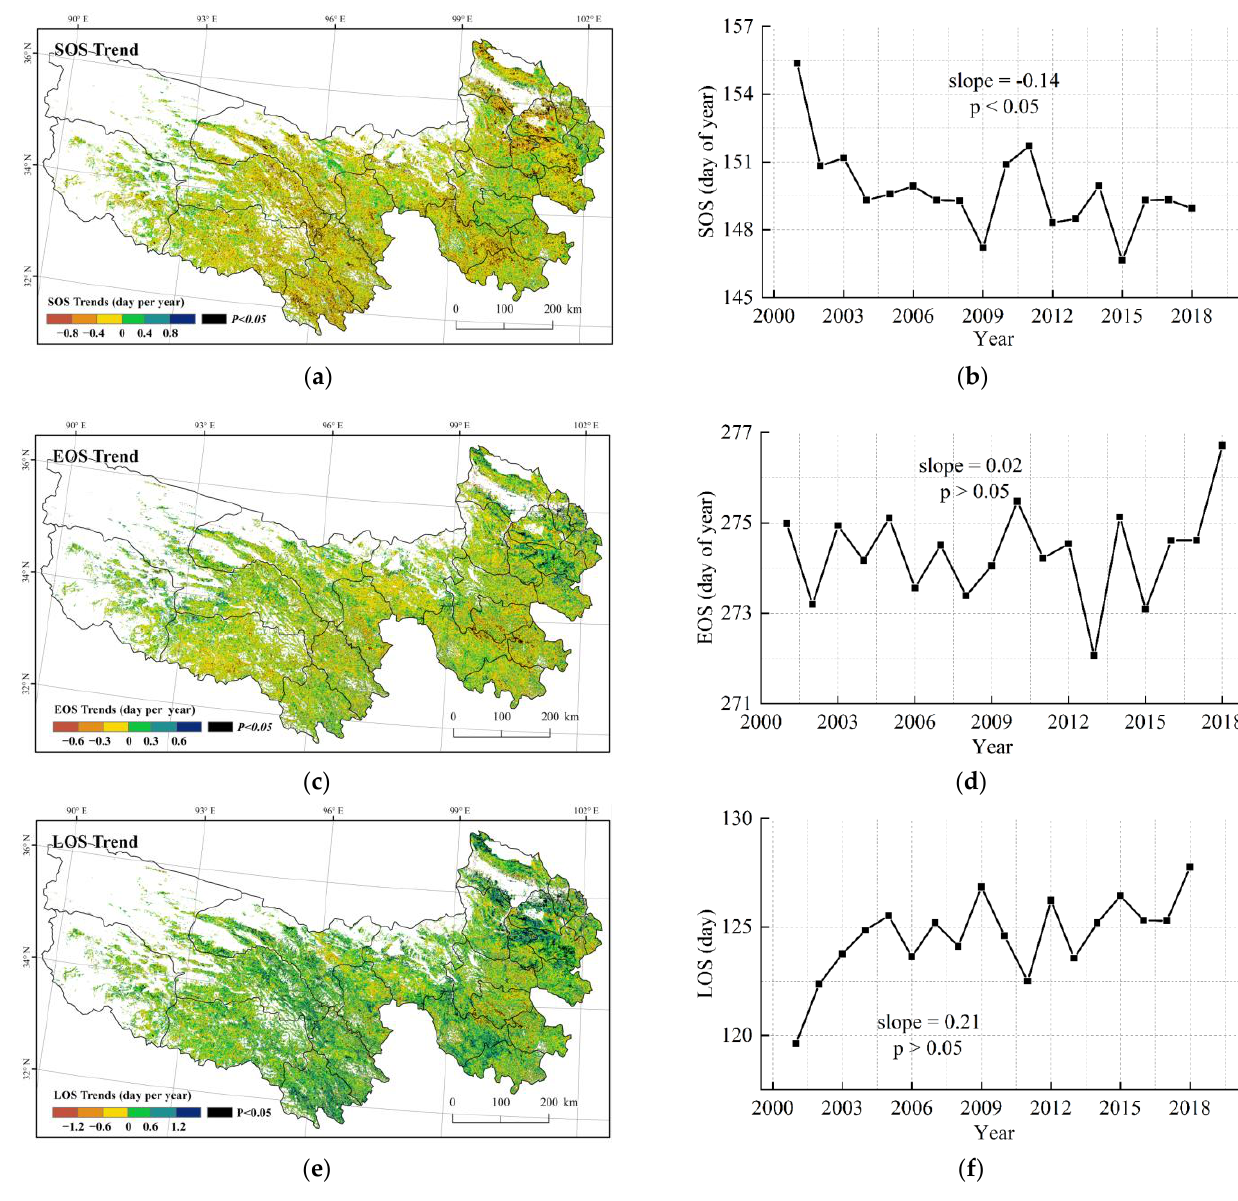
Figure 4. Variation trend distribution and interannual variation statistical diagram of the SOS, EOS and LOS of the vegetation in the Three-River headwaters region. ( a ) Spatial distribution pattern of the variation trend of the vegetation SOS in the Three-River headwaters region. ( b ) Interannual variation of the vegetation SOS in the Three-River headwaters region. ( c ) Spatial distribution pattern of the variation trend of the vegetation EOS in the Three-River headwaters region. ( d ) Interannual variation of the vegetation EOS in the Three-River headwaters region. ( e ) Spatial distribution pat- tern of the variation trend of the vegetation LOS in the Three-River headwaters region. ( f ) Interan- nual variation of the vegetation LOS in the Three-River headwaters region. Table 1. Statistics of the variation trend of the SOS, EOS and LOS of the vegetation in the Three- River headwaters region from 2001 to 2018.